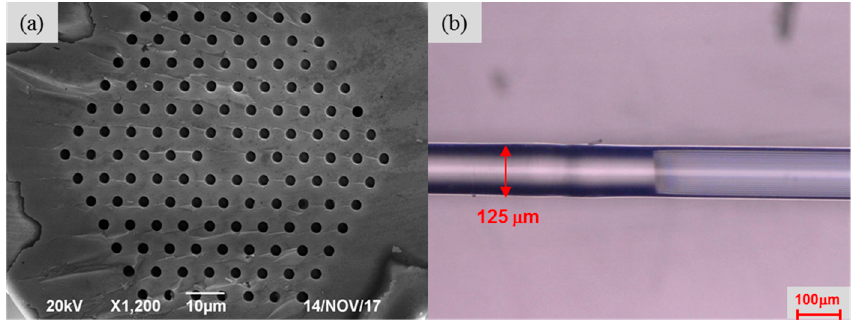
Figure 2. ( a ) SEM image of the cross section of PCF ( b ) microscope image of the fusion of TCF and PCF.